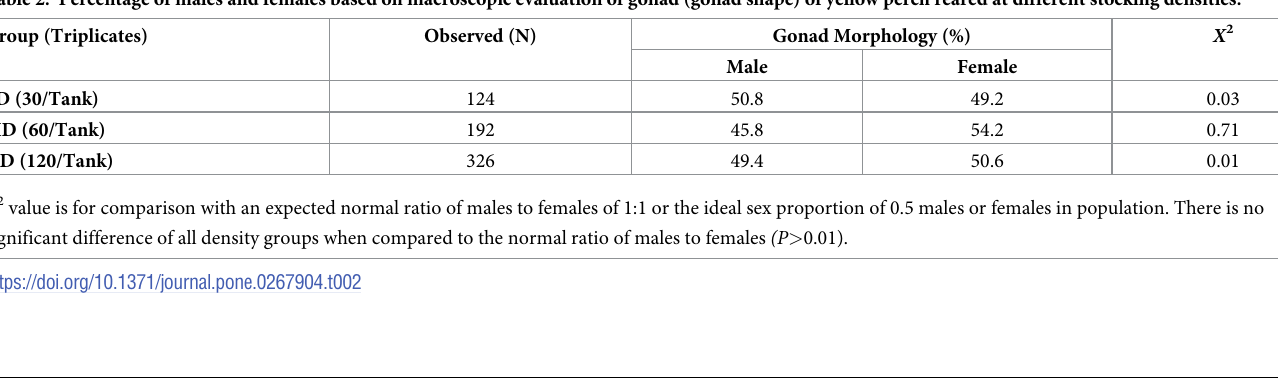
Table 2. Percentage of males and females based on macroscopic evaluation of gonad (gonad shape) of yellow perch reared at different stocking densities. Group (Triplicates)